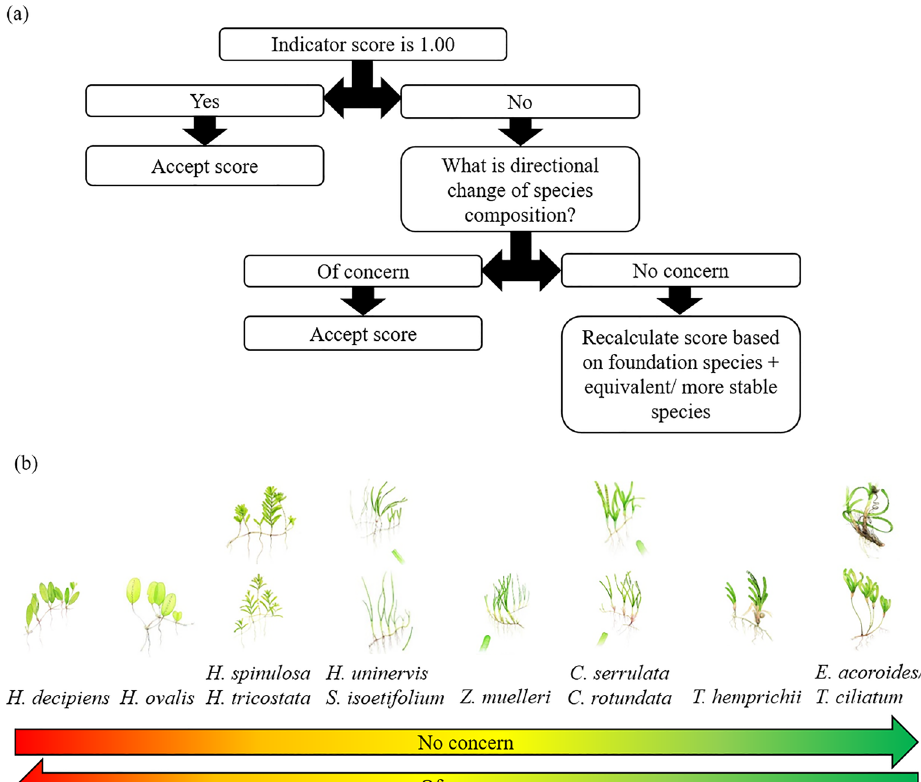
Figure 3. ( a ) Decision tree and ( b ) directional change assessment for grading and scoring seagrass species composition. The decision tree was developed to include all Queensland species so that it could be applied beyond Gladstone Harbour. These species are: Halophila decipiens , Halophila ovalis , Halophila spinulosa , Halophila tricostata , Halodule uninervis , Syringodium isoetifolium , Zostera muelleri , Cymodocea serrulata , Cymodocea rotundata , Thalassia hemprichii , Enhalus acoroides and Thalassodendron ciliatum .